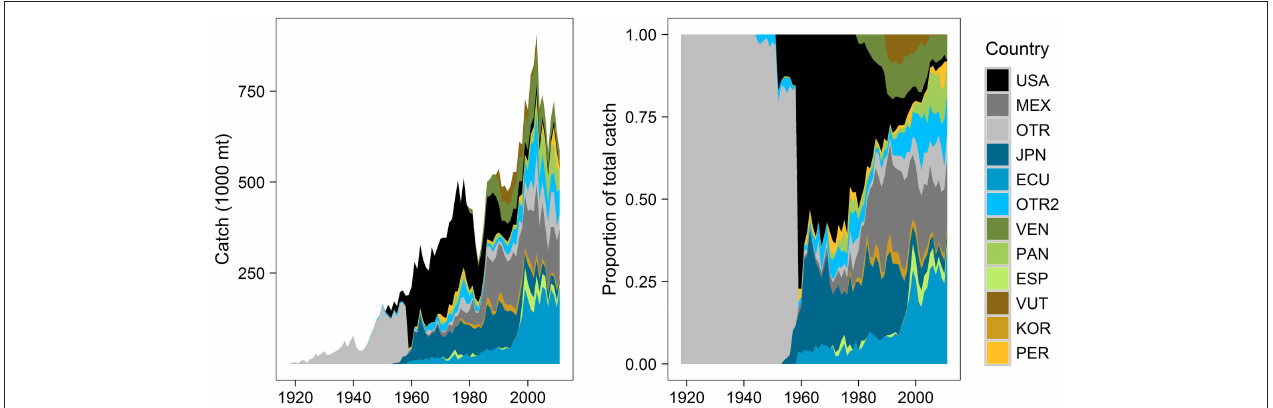
FIGURE 2 | Distribution of annual commercial fisheries catch (mt) by vessel flags (countries), for all species groups and gear types combined (1918–2011). Catch by country data are more detailed after the late 1950s, when the purse-seine fishery began and total fishing effort increased. The top 10 vessel flags by cumulative catch are shown (USA, United States; MEX, Mexico; JPN, Japan; ECU, Ecuador; VEN, Venezuela; PAN, Panama; ESP, Spain; VUT, Vanuatu; KOR, Korea; PER, Peru). OTR pools data from various countries to protect the identity of individual vessels or companies (different groupings each year, aggregated by the IATTC). OTR2 groups 17 countries not included in the top 10 list (Colombia, Taiwan, Chile, Canada, Costa Rica, Nicaragua, French Polynesia, China, Netherlands, Belize, Bermuda, El Salvador, Honduras, Guatemala, Cayman Islands, Senegal, Portugal). Data source: IATTC public data.